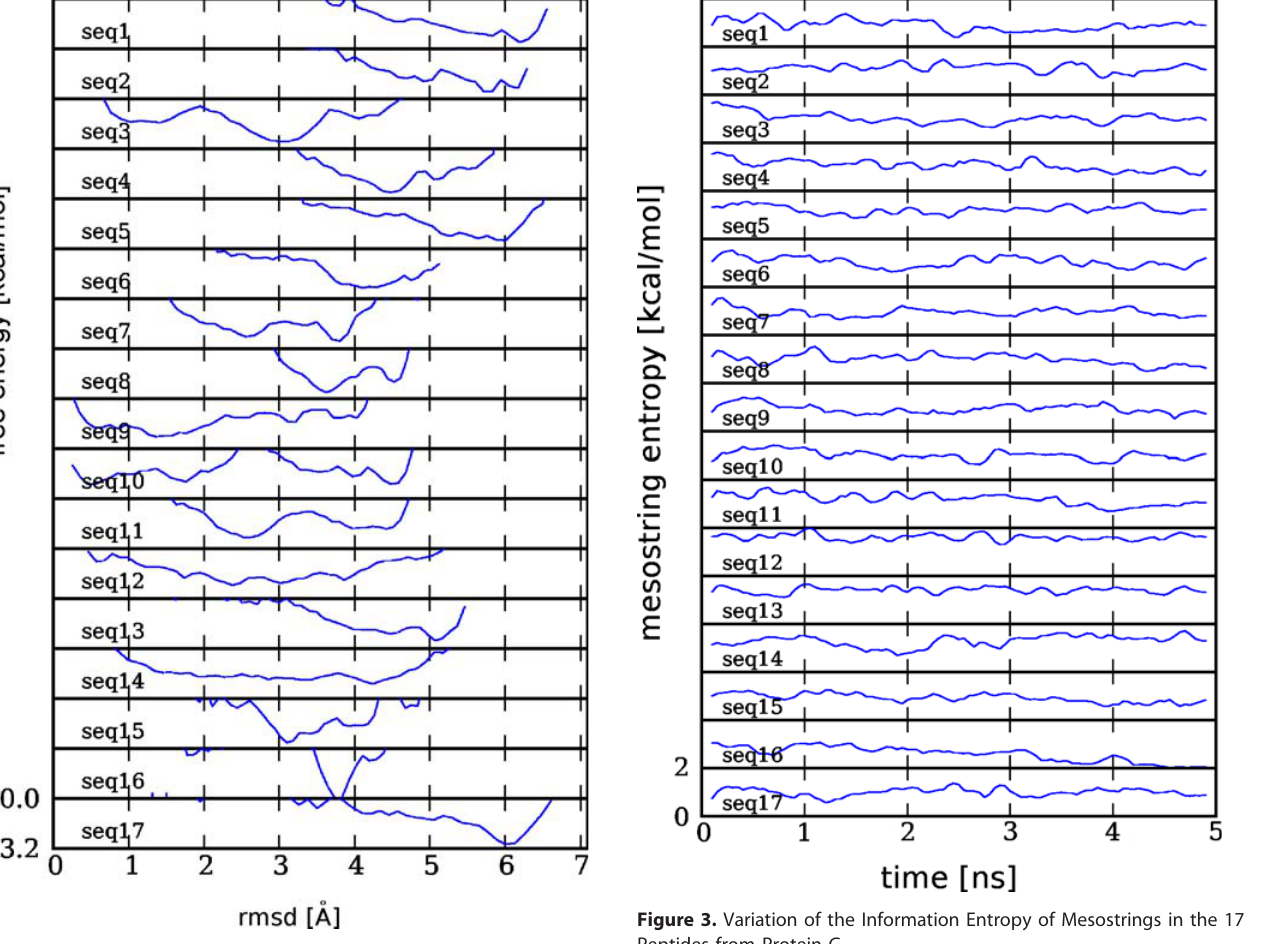
Figure 2. Free-Energy Profile of RMSD of Peptides from Protein G DOI: 10.1371/journal.pcbi.0020027.g002